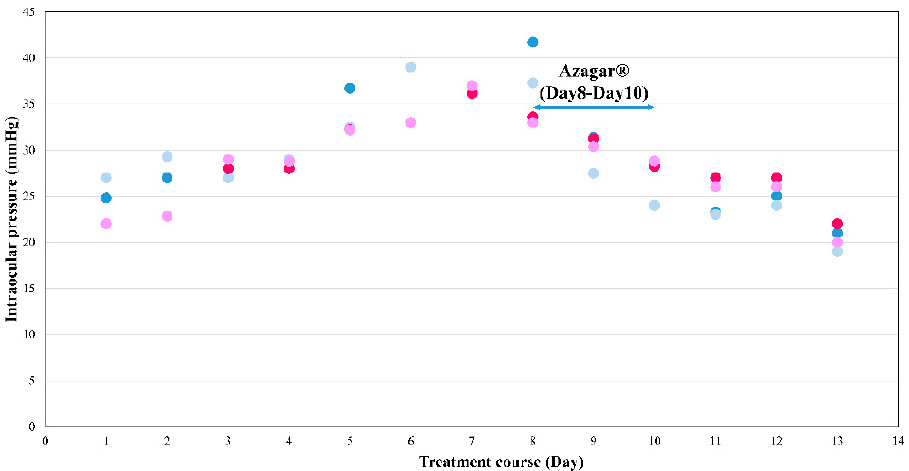
Figure 2. Intraocular pressure fluctuation while using oral dexamethasone under 12 mg/m 2 /day and 6 mg/m 2 /day (12 mg/m 2 /day with blue dots, 6 mg/m 2 /day with red dots). Azaga ® was only used at 12 mg/m 2 /day from Day 8–10. Deep blue and deep red dots represent the IOPs of the right eye, while light blue and light red dots represent the IOPs of the left eye.